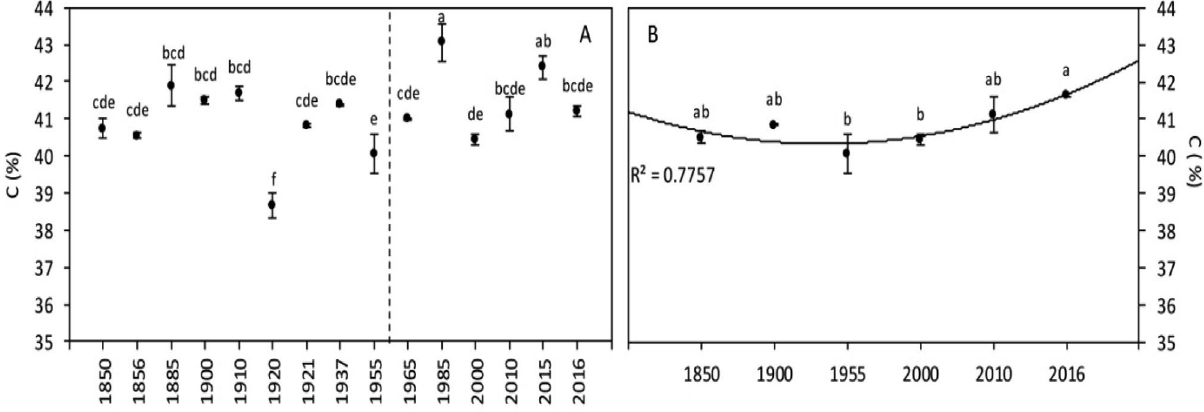
Figure 6. Wheat grain carbon content of global ( A ) and Broadbalk experiment ( B ) samples. The dashed line corresponds to the separation between the [1850–1955] and [1965–2016] periods, based on the increase of [CO 2 ]. Data are means ± standard errors (n = 3–14). The same letters indicate no statistically significant differences among years (Fisher’s LSD, p ≥ 0.05).